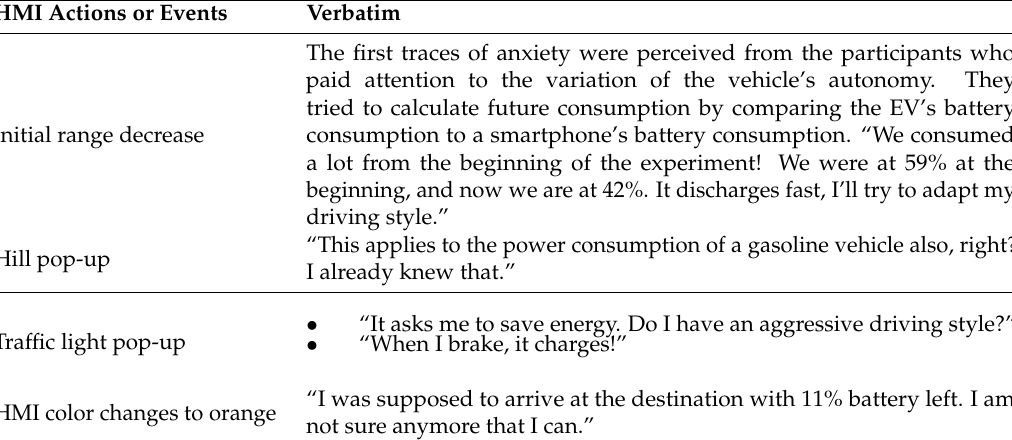
Table A2. Some verbatims pronounced during Scenario